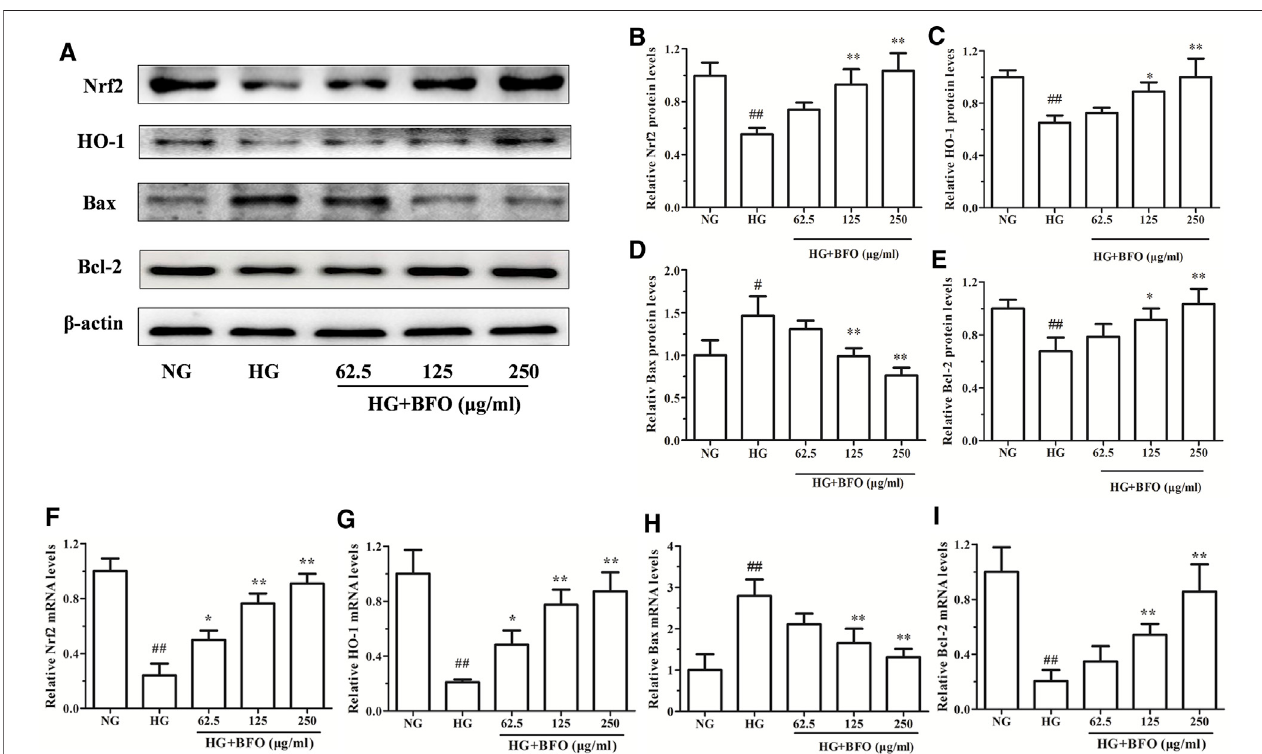
FIGURE 7 | Effect of BFO on the protein and mRNA expression in NRK-52E cells. (A) Representative bands of Nrf2, HO-1, Bax, and Bcl-2 obtained by western blotting. Relative protein levels (band density) of Nrf2 (B) , HO-1 (C) , Bax (D) , and Bcl-2 (E) were calculated by Image J. Relative mRNA levels of Nrf2 (F) , HO-1 (G) , Bax (H) , and Bcl-2 (I) in NRK-52E cells were determined by real-time PCR. All data are expressed as the mean ± SD. # p < 0.05 vs. normal glucose (NG), ## p < 0.01 vs. NG, * p < 0.05 vs. HG, ** p < 0.01 vs. HG.